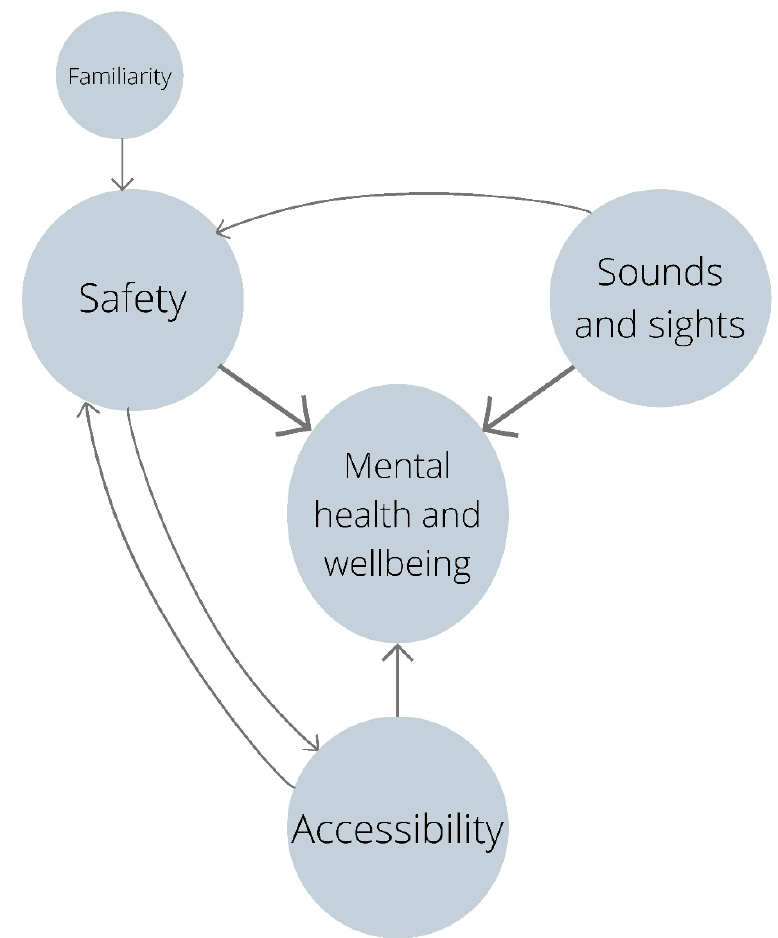
Figure 1. Visual representation of the links between the five key attributes of healthy environments highlighted by participants. The direction of the arrow infers the direction of influence.